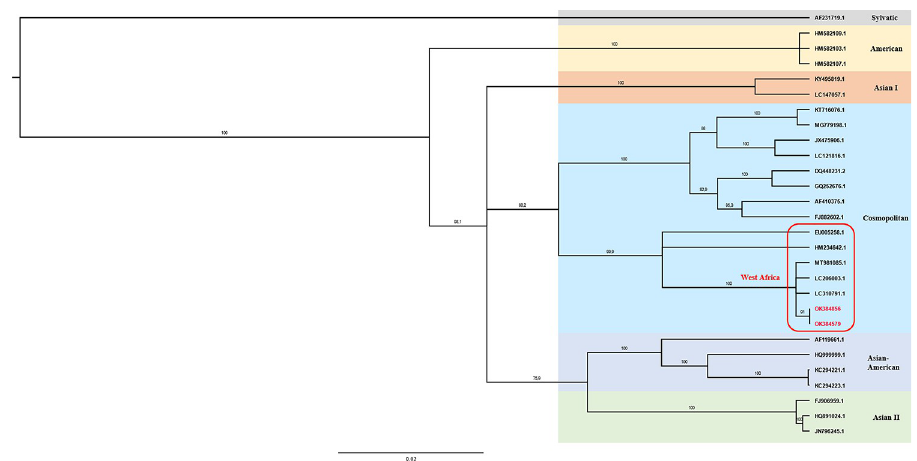
Fig 2. Phylogenetic tree of DENV-2 genotypes. Dengue virus partial sequences were analyzed by MEGA software with bootstrap support of 1000 replicates. The recent sequences are presented in red.